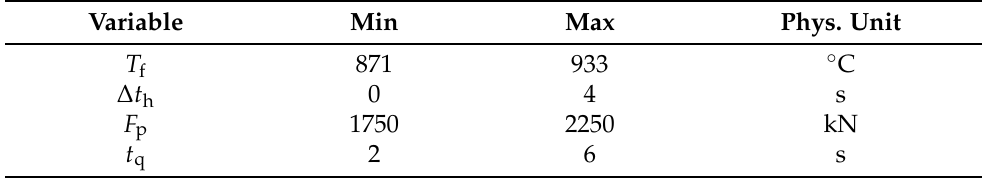
Table 2. Ranges for the process variables of press